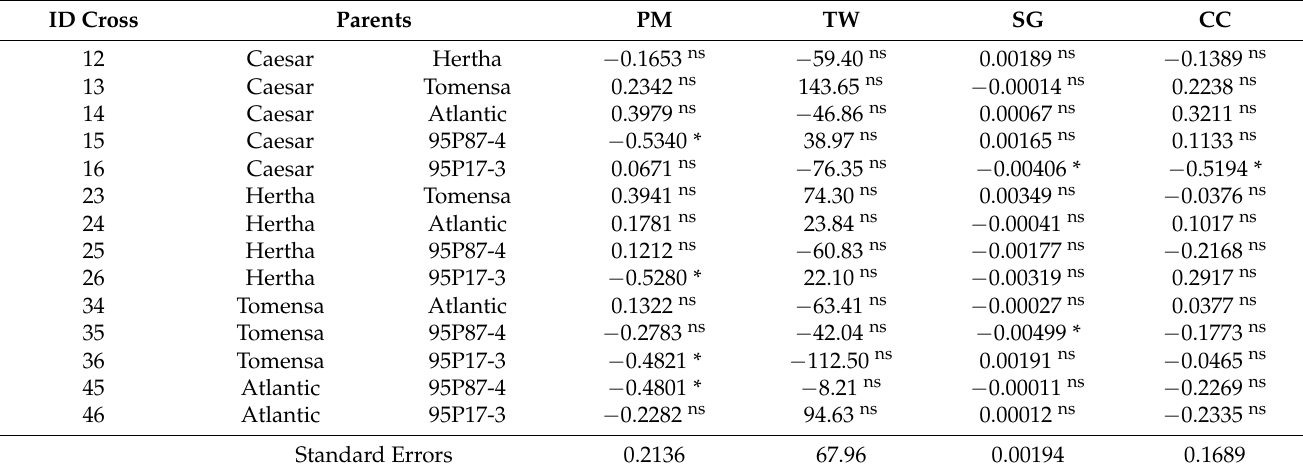
Table 9. SCA estimates and its standard errors of agronomic and quality traits.